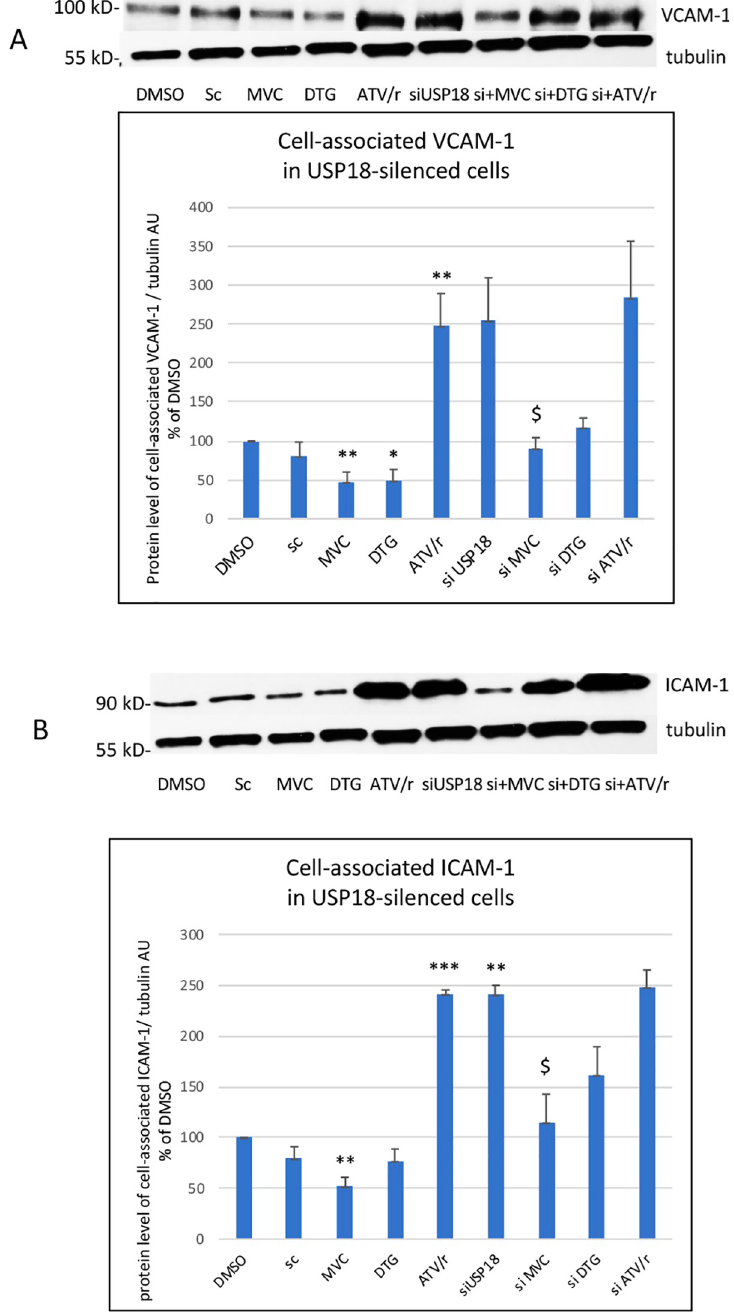
Fig 7. Effect of USP18-silencing on the level of cell-associated VCAM-1 and ICAM-1. A representative Western blot of VCAM-1 and tubulin as a loading control is shown in A and of ICAM-1 and tubulin in B. The histograms represent the mean+/-SEM value as compared to the DMSO control set at 100% of 3 independent experiments. Si- DMSO: control silenced for USP18, Si-DTG: DTG-treated cells silenced for USP18, Si-MVC: MVC-treated cells silenced for USP18, Si-ATV/r: ATV/r-treated cells silenced for USP18 The comparisons used Welch’s correction of Student T-test. � p < 0.05, �� p < 0.01, ��� p < 0.001 versus control (DMSO) $ p < 0.05, versus Si-DMSO.